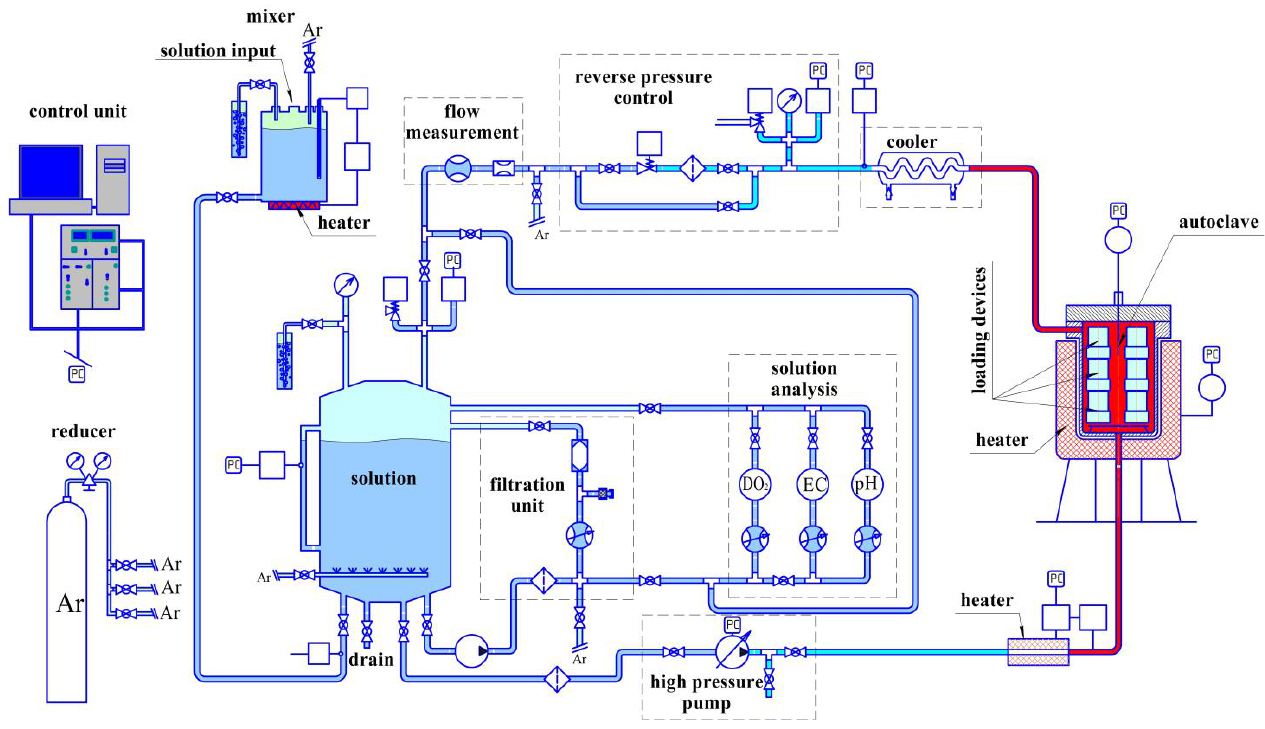
Figure 1. The autoclave scheme.